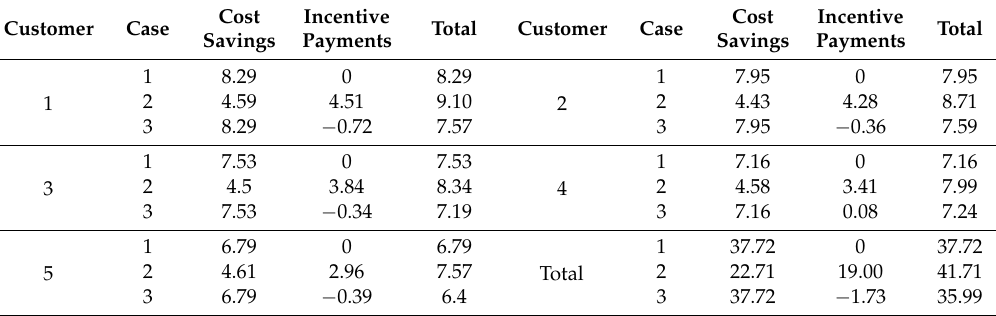
Table A3. Profit of customers on Day 3 (unit: